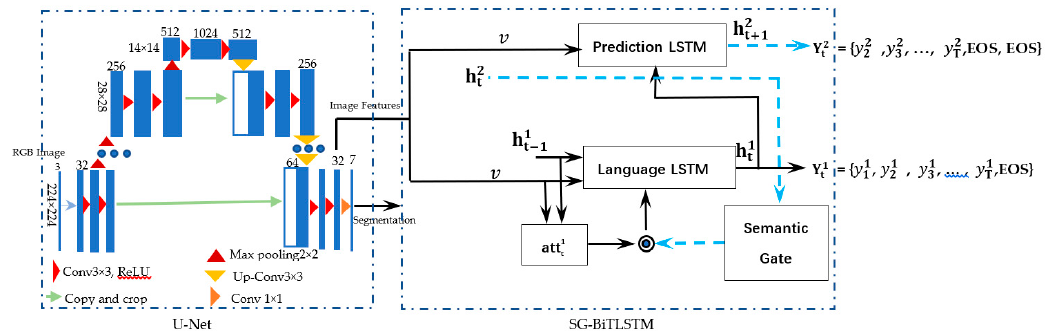
Figure 4. The main architecture of the semantic gate and a bi-temporal long-short term memory network (SG-BiTLSTM). The U-Net is used as an encoder. The decoder of this structure consists of two LSTMs: a language LSTM and a prediction LSTM.